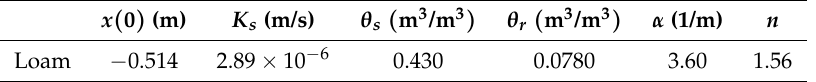
Table 1. The initial condition and parameters of the investigated loam soil